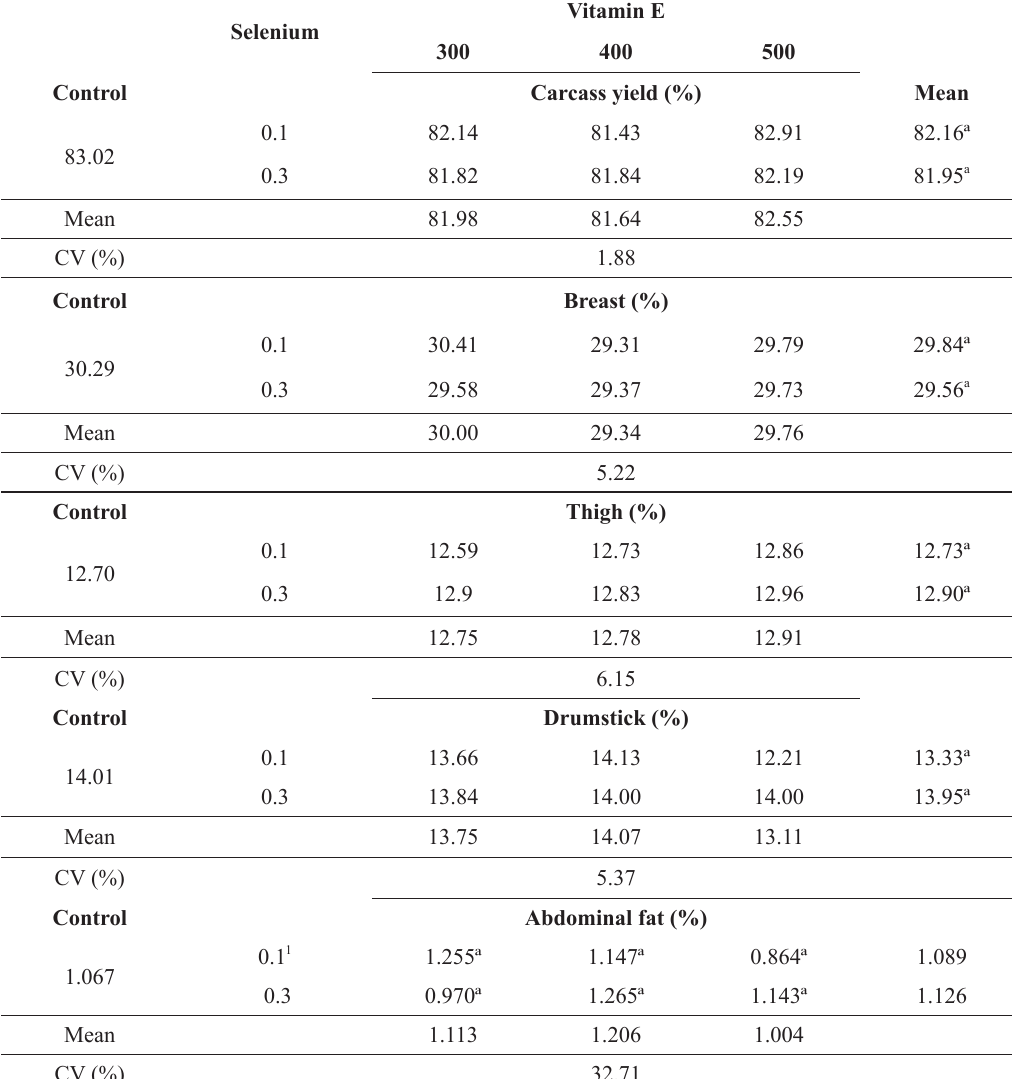
Yields of carcass, abdominal fat, and major cuts of broilers fed different levels of selenium and vitamin E. Vitamin E Selenium